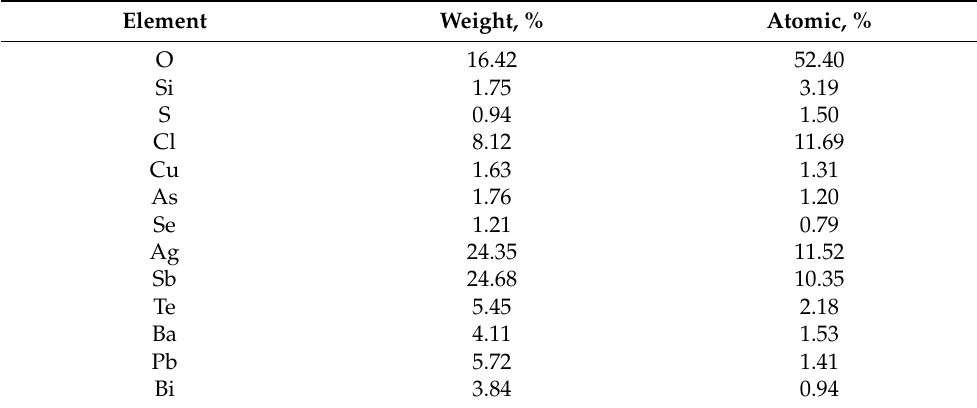
Table 7. Semi-quantitative analysis of residues from leaching ClO − /OH − .